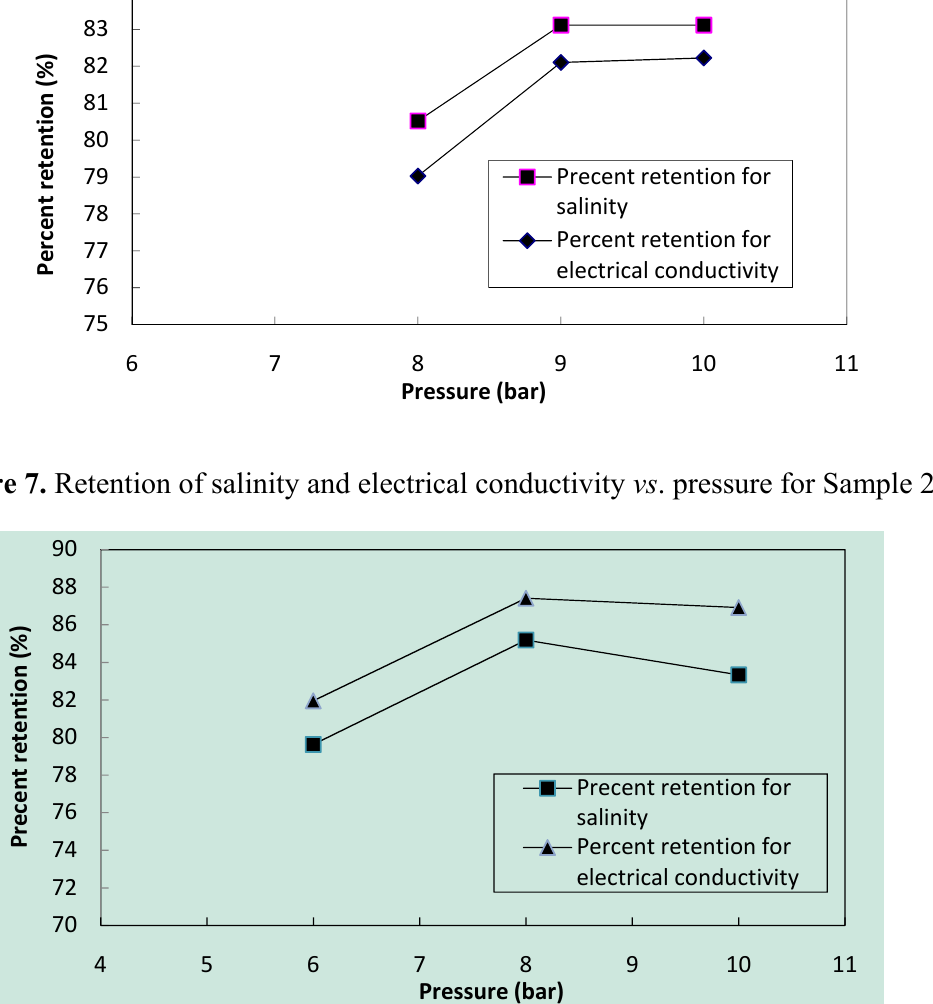
Figure 8. Retention of salinity and electrical conductivity vs . pressure for Sample